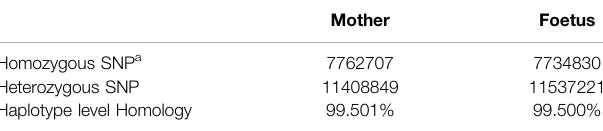
TABLE 3 | Genome-wide SNPs compared to Bos taurus